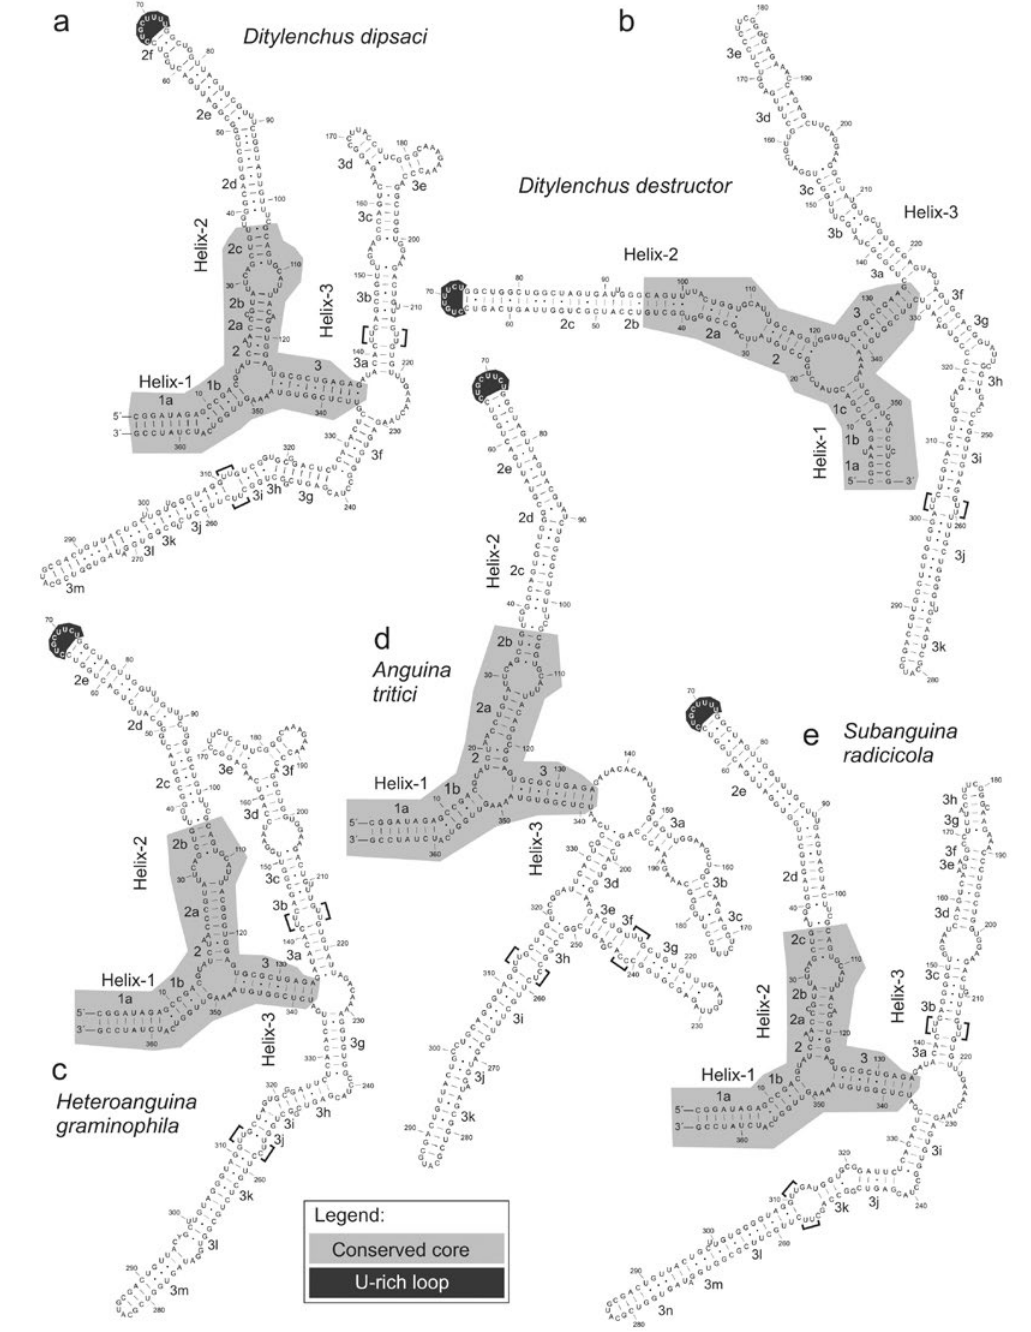
Figure 4. Secondary structure models of the D2-28S rRNA expansion segments for Ditylenchus dipsaci ( a ), D. destructor ( b ), Heteroanguina graminophila ( c ), Anguina tritici ( d ) and Subanguina radicicola ( e ). The models were computed by an energy- minimatization approach using the Mfold program and final adjustments of folded structures were performed with the RNAViz software. Bonds between C:G and U:A nucleotides are indicated by a straight line; bonds between U:G are indi - cated by a closed circle. The conserved core is highlighted in light gray field, the U-rich loop is labeled by dark grey field, and the pyrimidine mismatches are marked with square